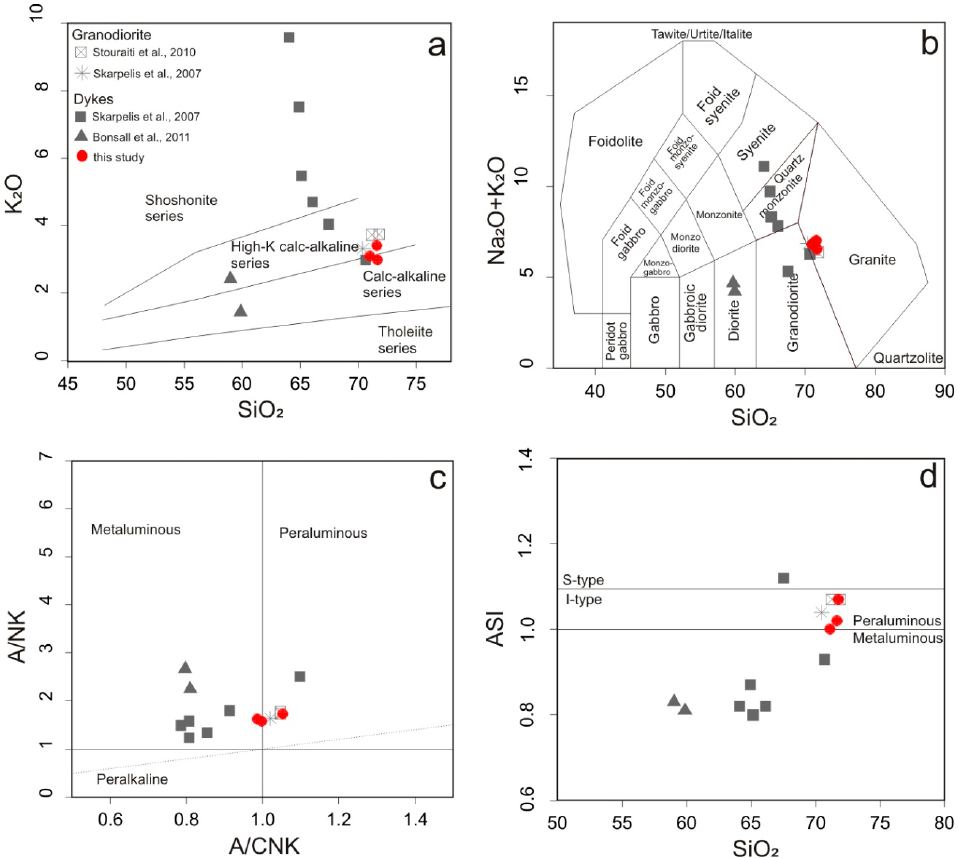
Figure 4. ( a ) Classification of magmatic rocks in the Lavrion district in terms of SiO 2 vs K 2 O [25]; ( b ) total alkali vs. silica diagram of igneous rocks hosting the porphyry-style mineralization in the Serpieri deposit, Kamariza. Rock fields are from Middlemost [26]; ( c ) A/CNK vs A/NK plot from Shand [27] that discriminates metaluminous, peraluminous, and peralkaline compositions. A/NK = molar ratio of Al 2 O 3 /(Na 2 O + K 2 O); A/CNK = molar ratio of Al 2 O 3 /(CaO + Na 2 O + K 2 O); ( d ) ASI vs SiO 2 plot discriminating metaluminous, peraluminous and S- from I-type compositions (after Maniar and Piccoli [28]). ASI = Al/(Ca-1.67P + Na + K). Literature data are from Stouraiti et al. [29], Skarpelis et al. [24] and Bonsall et al. [5].